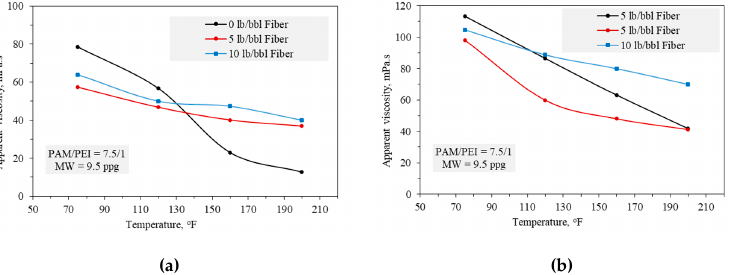
Figure 7. Impact of cedar fiber on (a) AV and (b) PV of the 7.5 wt.% PAM/PEI ‐ based drilling fluid at 200 °F.